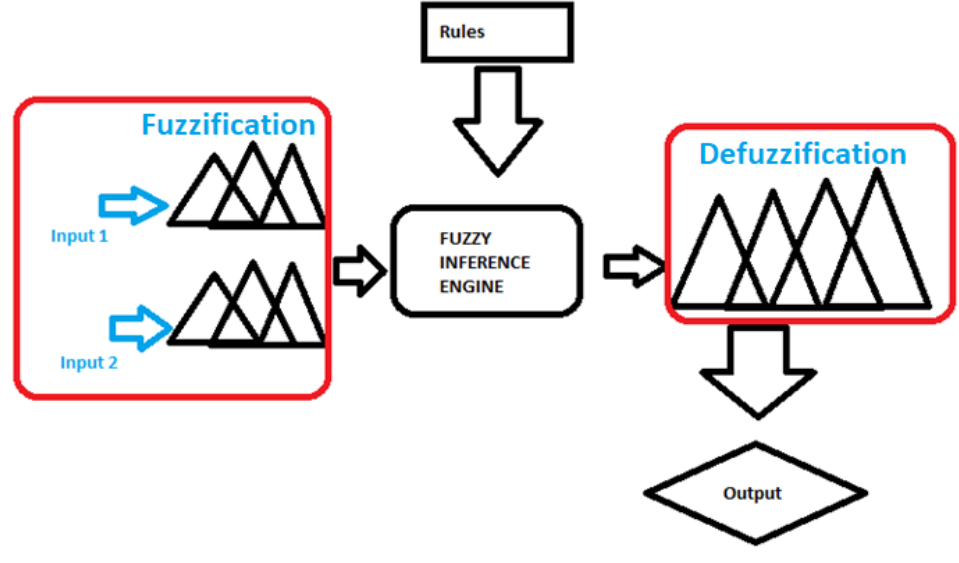
Figure 4. Fuzzy logic model